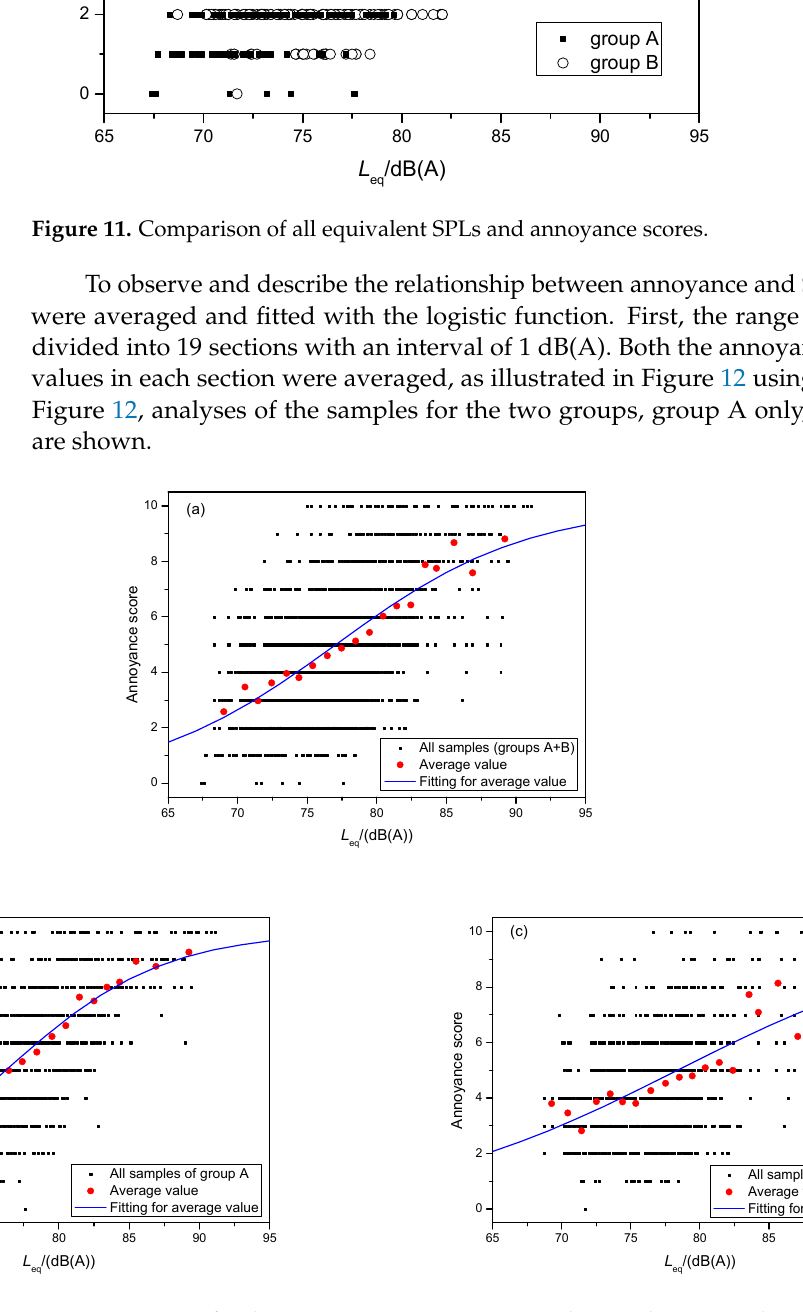
A logistic function is suggested as a method to describe average scores [50,51]; it is defined as: